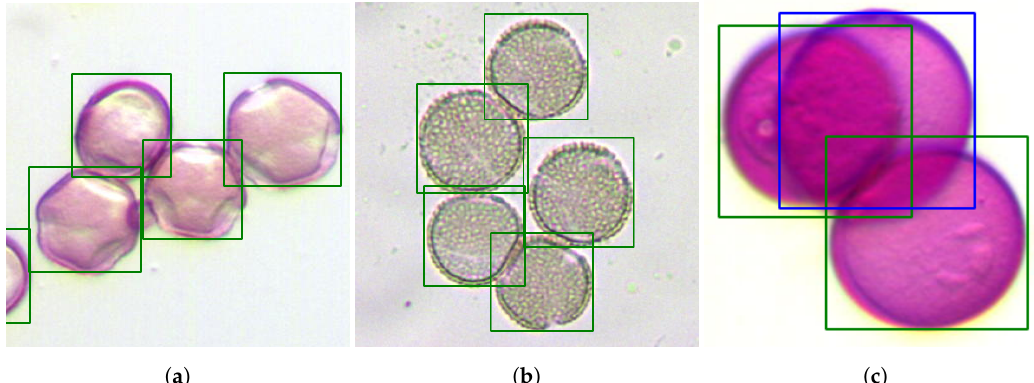
Figure 11. ( a ) A sample of the successful location of all Quercus grains despite distinct visible morphology, ( b ) a second sample of Olea with different levels of tinting and successful management despite the deformation of the edge, and ( c ) the highly overlapping sample of Dactylis m which did not allow the separation of the central